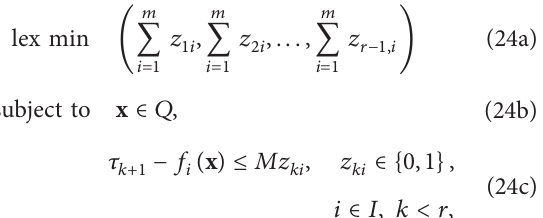
solution of the throughputs where each demand uses only one path. All the solution methods above do not apply. If the number of possible distinct outcomes 𝜏 1 < 𝜏 2 < ⋅ ⋅ ⋅ < 𝜏 𝑟 is small, one can construct counting functions, where the 𝑘 th counting function value is the number of times the 𝑘 th dis- tinct worst outcome appears in the solution. That means that one introduces functions ℎ 𝑘 ( y ) = ∑ expressing the number of values 𝜏 𝑘 in the outcome vector y